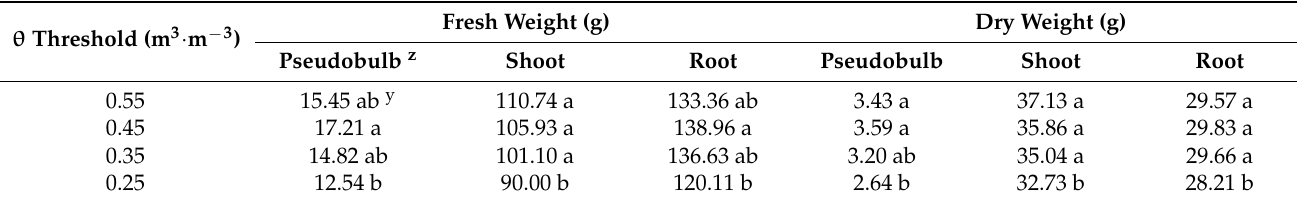
Table 2. Fresh and dry weight of 1-year-old cymbidium “Hoshino Shizuku” grown with FDR sensor-based irrigation system for 42 weeks, as influenced by 0.25, 0.35, 0.45, and 0.55 θ thresholds (m 3 · m − 3 ). Fresh Weight (g) Dry Weight (g) θ Threshold (m 3 · m − 3 ) Pseudobulb z Shoot Root Pseudobulb Shoot Root 0.55 15.45 ab y 110.74